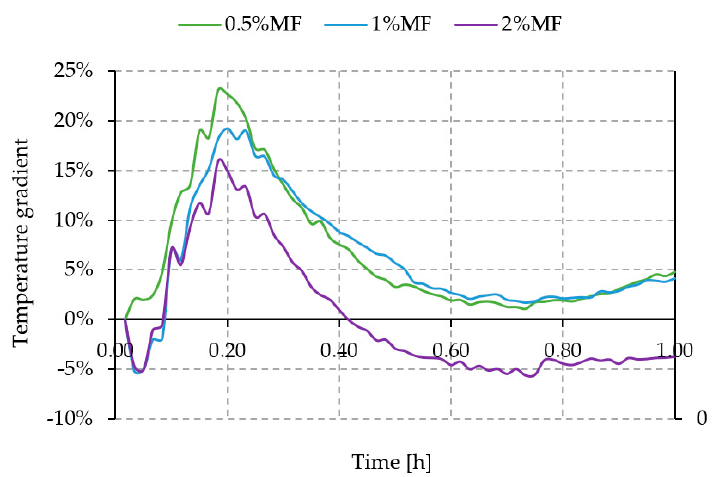
Figure 9. Temperature difference between the pure geopolymer matrix and the geopolymer matrix with variable melamine content.